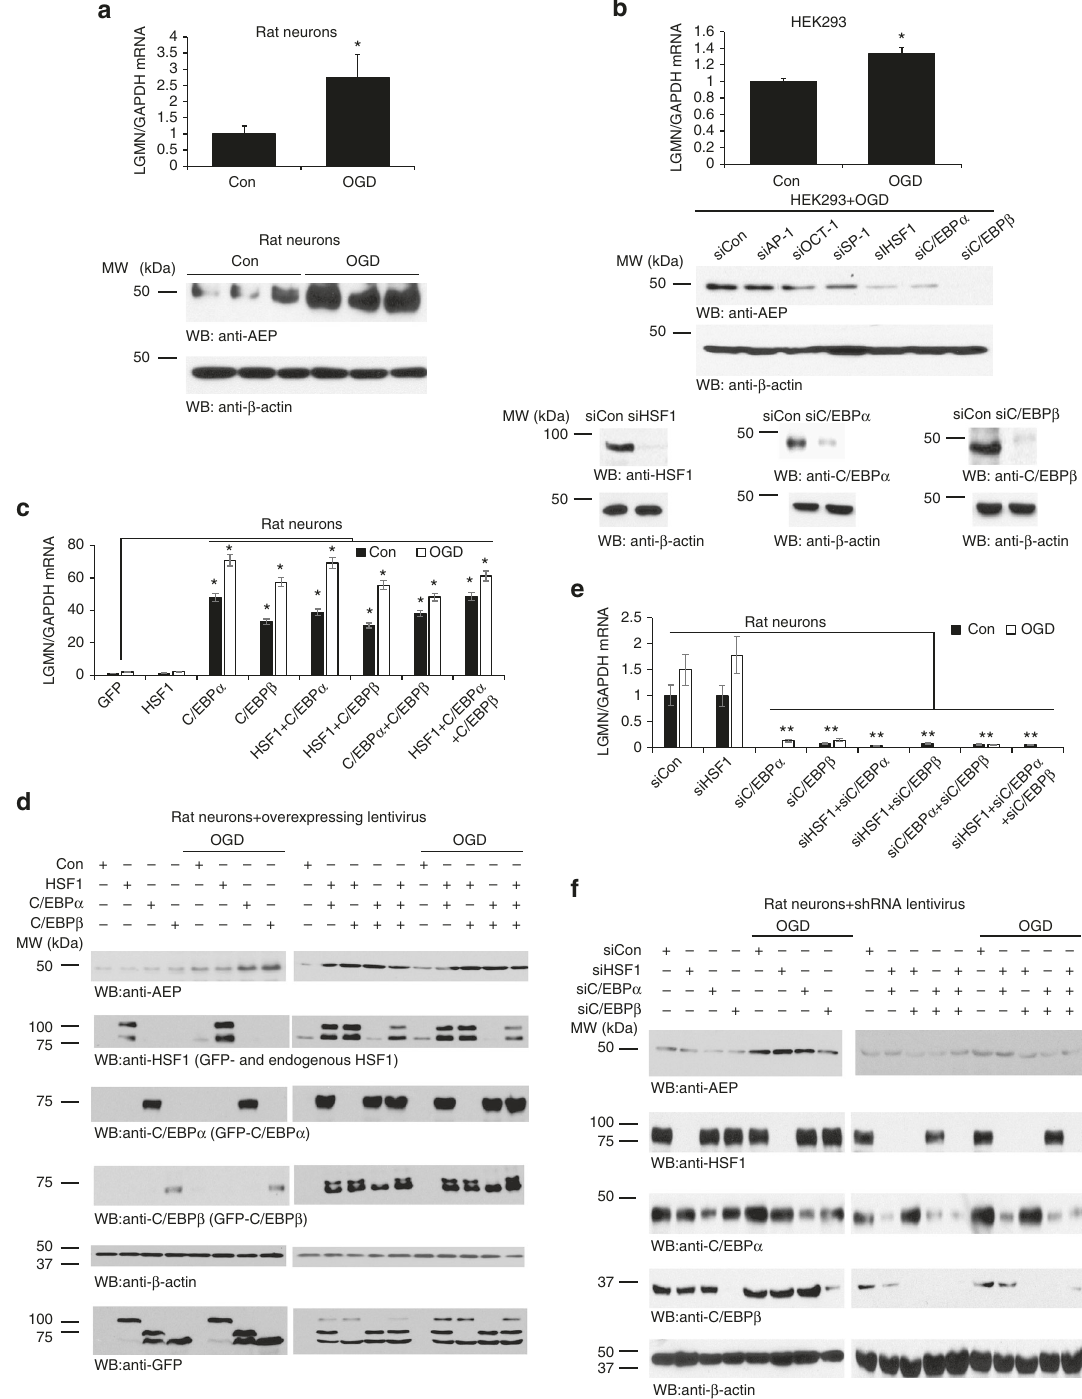
Fig. 1 Oxygen glucose deprivation (OGD)/reperfusion promotes delta-secretase expression, and C/EBPs control delta-secretase expression in primary neurons. a OGD increases delta-secretase expression in neurons. Primary cultures of neurons from rat E17 embryos were seeded in a six-well plate. At DIV 7, neurons were treated with OGD for 2h. After 24h of recovery, neurons were collected for western blotting and real-time PCR analysis. At least three wells of neurons were tested in each experiment. * P <0.05. b OGD increases delta-secretase expression in HEK293 cells. After 10h of OGD treatment, HEK293 cells were recovered for 12h; mRNAs were extracted and real-time PCR analysis. All real-time PCR experiments were repeated at least three times. β -actin was employed as a loading control. HEK293 cells were seeded and transfected with the various siRNAs. Forty-eight hours post transfection, all cells were given the OGD/recovery treatment. Cells lysates were analyzed by western blotting (middle panels). Knockdown of HSF, C/EBP α , and C/EBP β was con fi rmed by western blotting (lower panels). c , d Overexpression of HSF1, C/EBP α , and C/EBP β by lentivirus transduction of primary neurons increases delta-secretase expression. e , f Knock-down of these genes via lentivirus-mediated shRNA expression in primary neurons decreases delta-secretase expression. The primary cultures were treated by OGD 2h/reperfusion for 24h. Neurons were collected and lysed. The mRNA and protein levels of AEP were detected by real-time PCR ( c , e ) or western blotting analysis ( d , f ). HSF1, C/EBP α , and C/EBP β ’ s expression levels were detected by western blotting as well ( d , f ). Western blot data in a , b , d , and f are representative of three independent experiments. Real-time PCR data in a – c , e represent mean±s.e.m. of three independent experiments ( a – c , e : * P <0.05, Student ’ s t